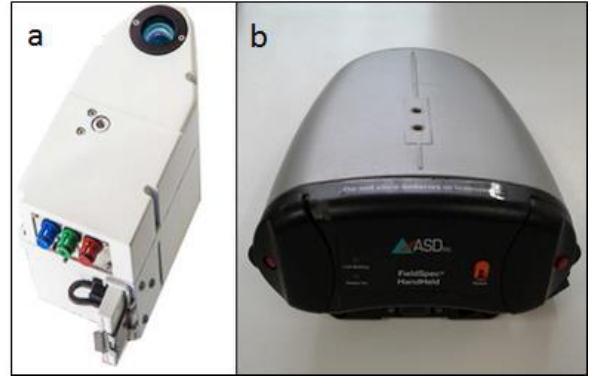
Figure 1. (a) Hyperspectral camera. (b) Espectrometer. Table 1: Image